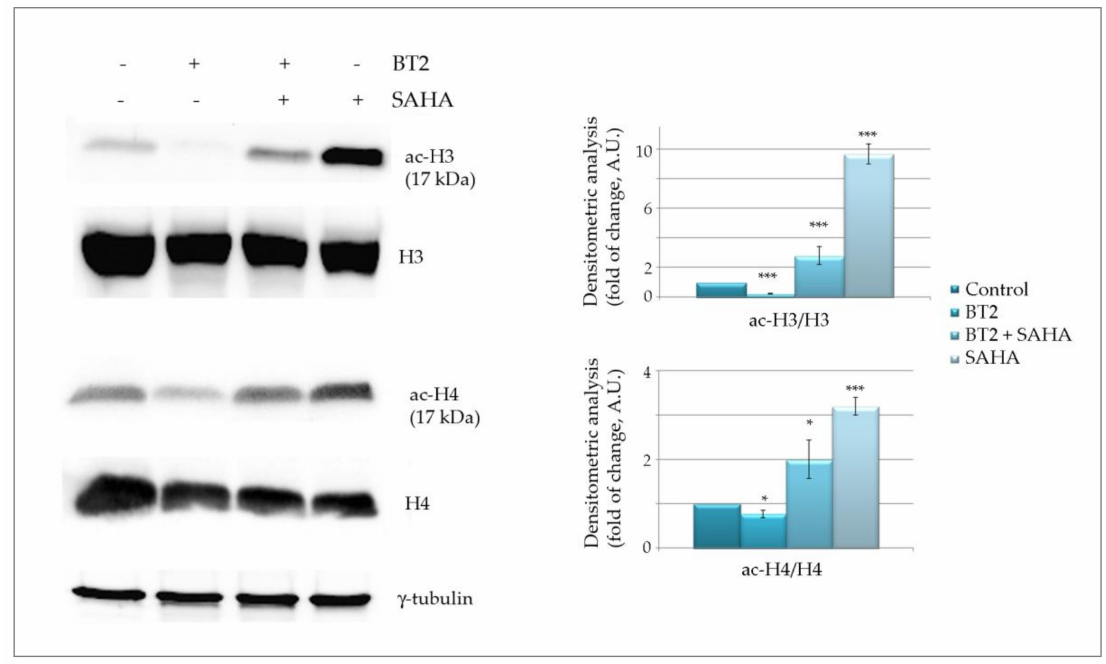
Figure 7. Tributyltin(IV) butyrate (BT2) reduces the effect of the HDAC inhibitor SAHA on histone acetylation. The figure shows Western blot analysis of acetylated-H3 and H4 histones after cell treatment for 48 h with 0.5 µ M BT2 (lane 2) or 24 h treatment with 10 µ M SAHA used alone (lane 4) or after pre-treatment with BT2 (24 h) followed by other 24 h of incubation with the HDAC inhibitor (lane 3). The ratio between acetylated histones and total histone levels was quantified. Representative blots of three independent experiments and densitometric analysis are shown. (*) p -value < 0.05; (***) p -value < 0.001 compared with untreated cells. N.S. = not